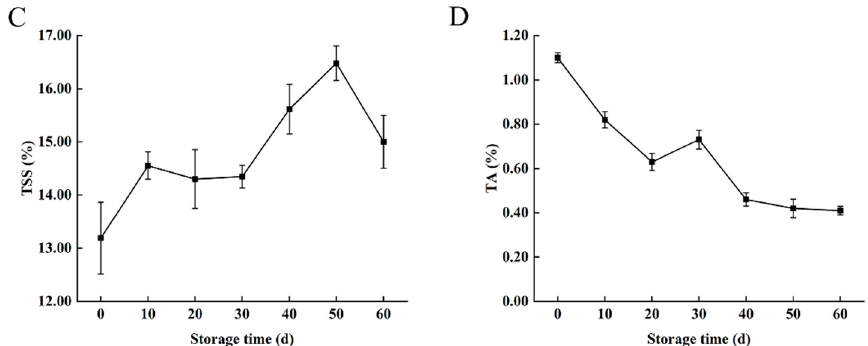
Figure 1. Physiological characteristics of ‘Fengtang’ plum fruits: ( A ) Firmness, ( B ) Respiration rate, ( C ) TSS, and ( D ) TA.